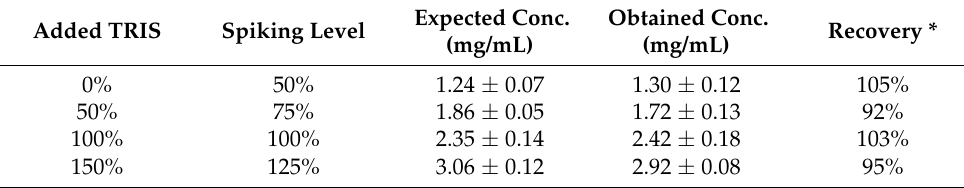
Table 1. Accuracy summary.